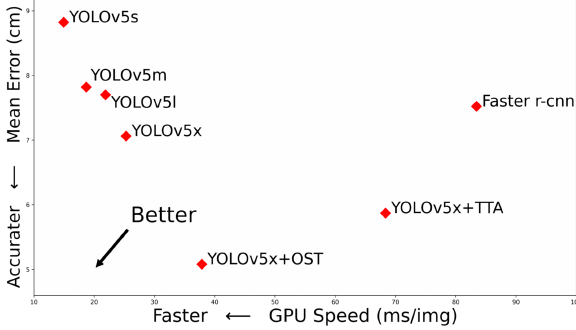
Figure 12. The speed and accuracy of seven variations MOHE-Net based on the object detection backbone are plotted in mean error (centimeters) and GPU speed ( milliseconds). Black arrow indicates the faster speed and less error is better meeting our